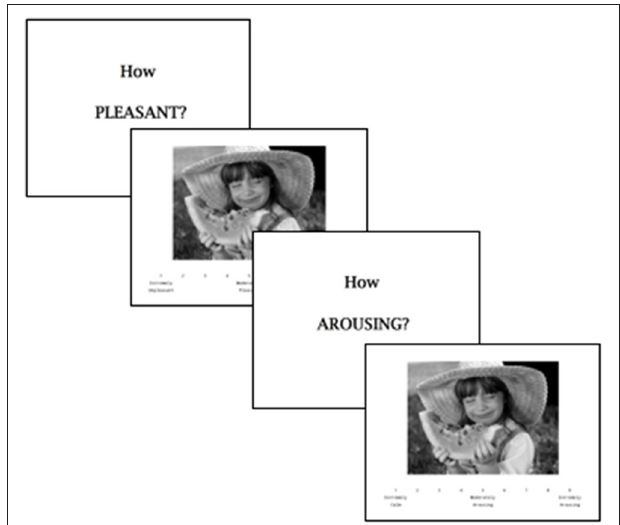
FIGURE 1 | Schematic representation of a single trial in the International Affective Picture Rating System (IAPS) task ( 36). In this example, pleasantness and arousal ratings must be made for a positive-valence